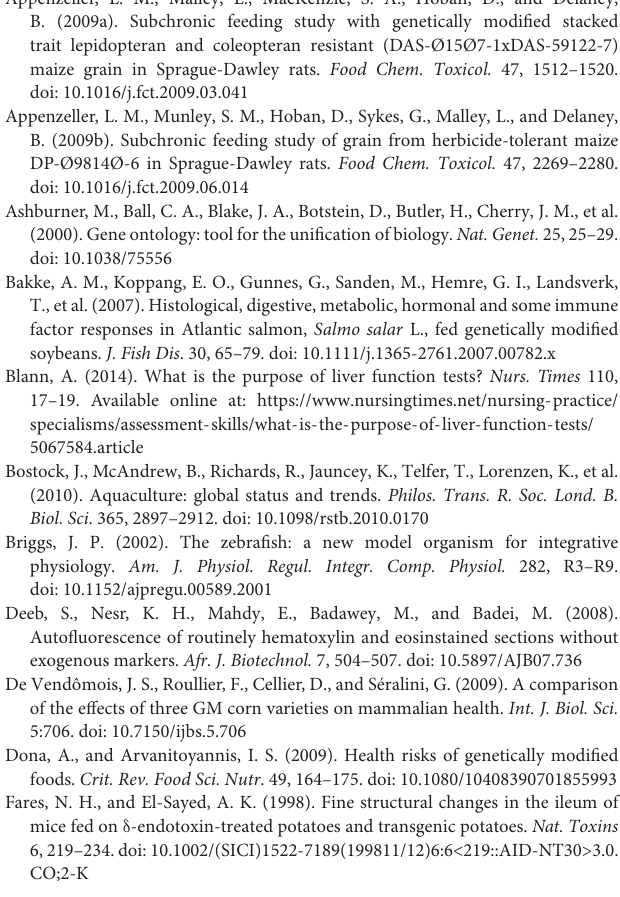
Supplementary Figure 2 | Nucleotide composition bias and reproducibility. Supplementary Figure 3 | Different gene expression levels and functional analysis between TFD and control groups. (A) The transcript expression boxplot of each sample. (B) The different PCA of gene expression between the TFD and control samples. (C) Heat map of liver tissues from TFD and control subjects (Distance metric: Pearson correlation; Linkage rule: Average Linkage). (D) Volcano plot of different gene expression between two groups. Supplementary Table 1 | Statistics for the raw reads quality clean. Supplementary Table 2 | High-quality reads mapped against reference genome.